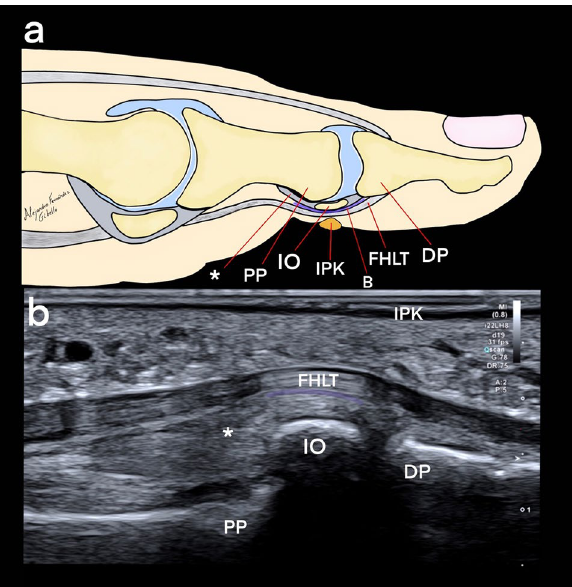
Figure 5. Comparison between a sketch ( a ) and an ultrasound sagittal view ( b ): asterix* plantar plate, IO interphalangeal ossicle, PP proximal phalangeal, DP distal phalanx, FHLT flexor hallucis longus tendon, IPK intractable plantar keratosis, B bursa.